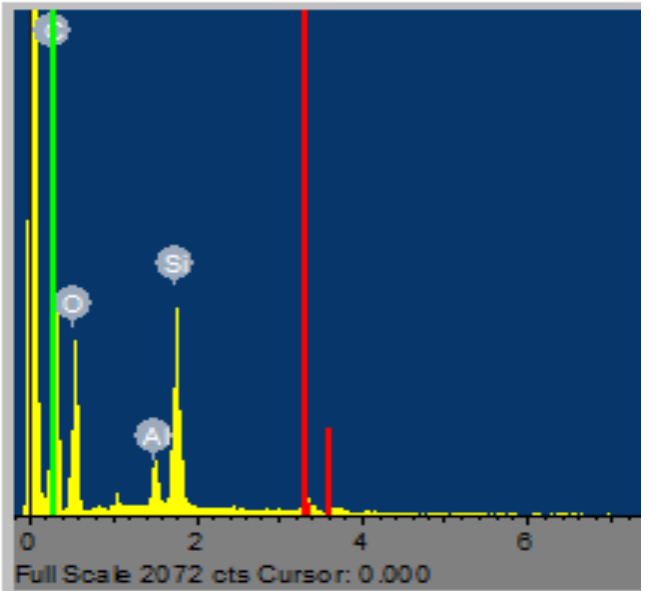
Figure 10. EDX spectrum of particles during polishing of granite (polishing speed—1000 rpm; feed rate—508 mm/min; abrasive grit size—60; pressure—0.2 bar).